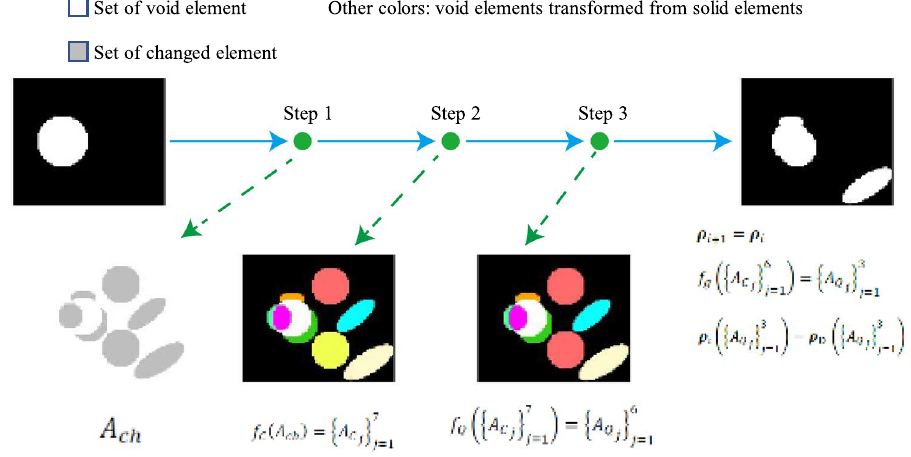
Figure 4. The path for the variables update in the QSDV method when the maximum genus G is assumed to be